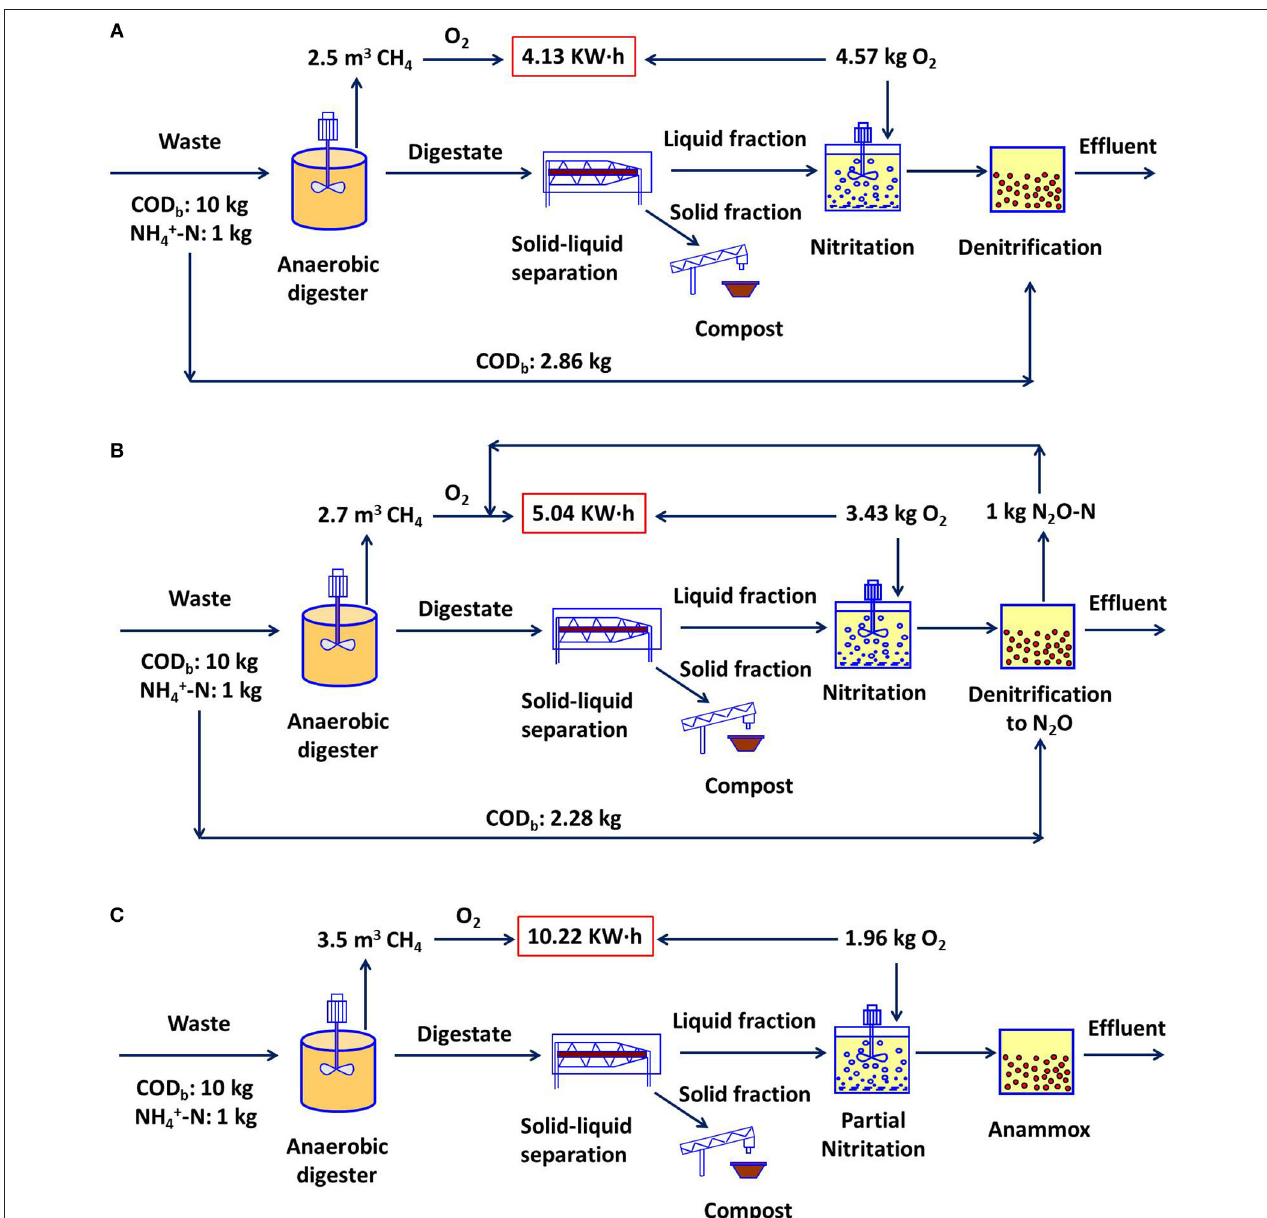
FIGURE 3 | Comparison of (A) conventional nitrification–denitrification, (B) CANDO, and (C) partial nitrification-anammox processes with respect to energy recovery. Calculations were carried out considering a generic waste with inlet biodegradable COD and NH + 4 -N concentrations of 10 kg/m 3 and 1kg N/m 3 , respectively. To calculate overall energy production, energy consumption associated with aeration was estimated using an average factor of 1 kW · h/kg O 2 transferred while energy production, as electricity, was estimated taken into account an efficiency factor of 35% for the biogas